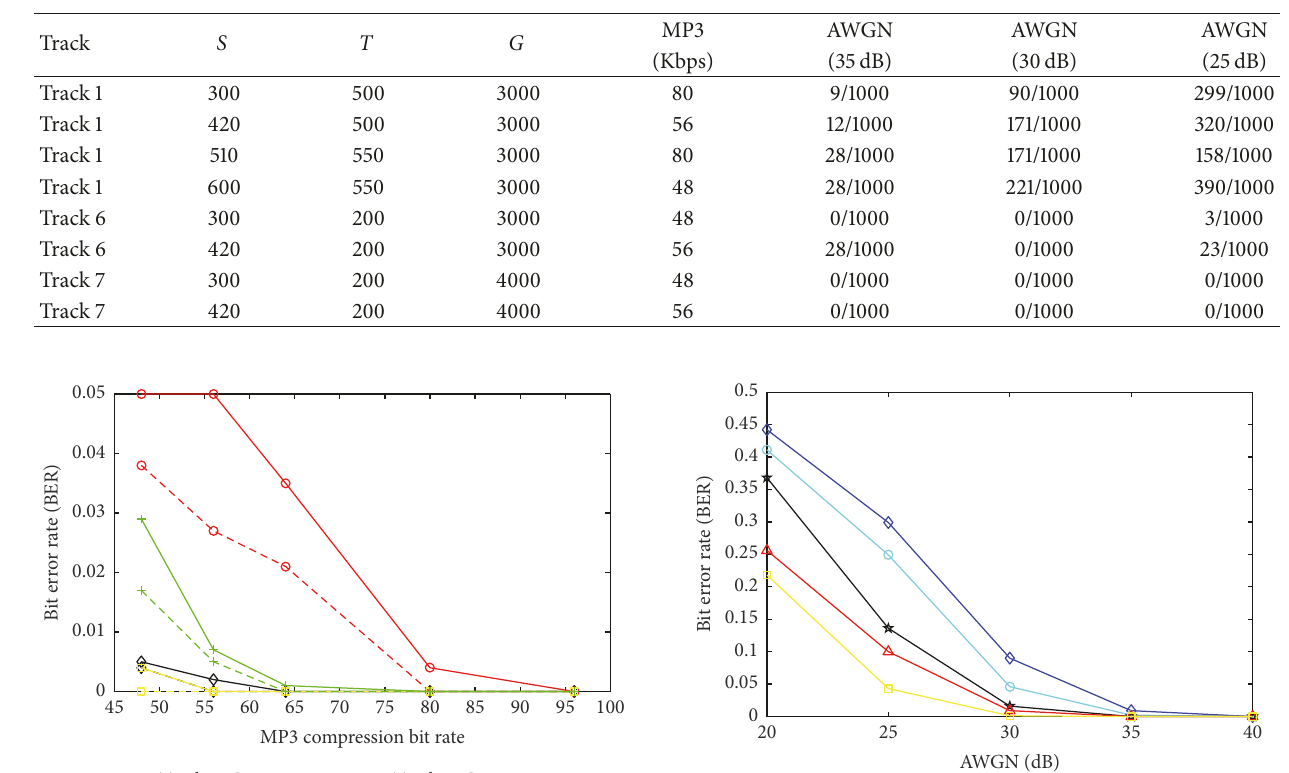
Table 2: Performance of the proposed method with different length of a frame 𝑆 on track 1.